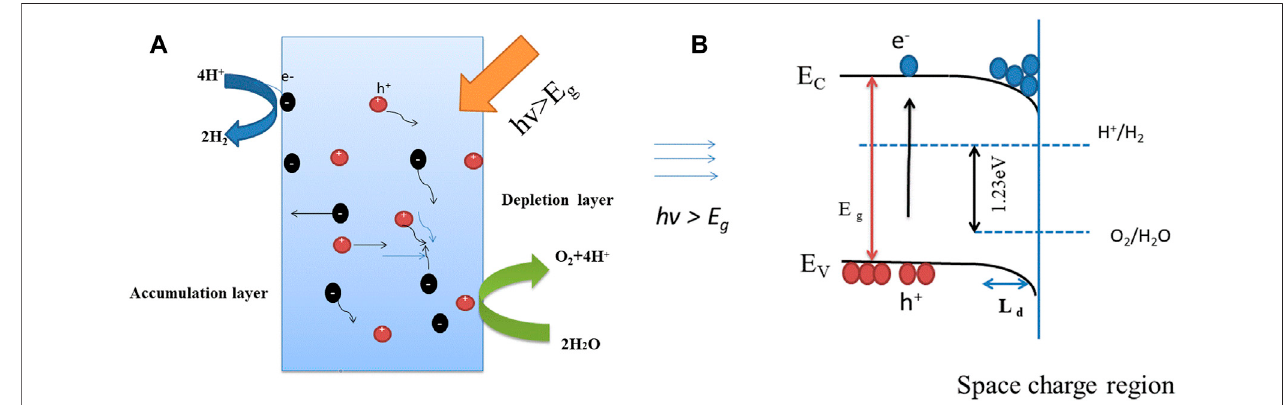
FIGURE 6 | (A) Schematic depiction of the dynamic behaviors of charge carriers upon photoexcitation. (B) Energy band diagram of BNFCO-15 for water splitting. The band bending at the surface is caused by the space-charge region of depletion or accumulation